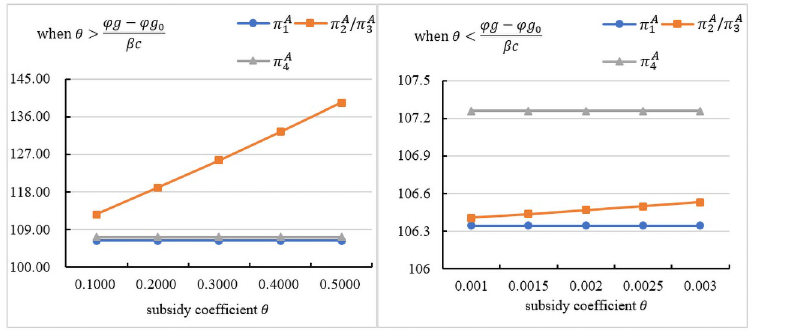
Fig 5. The influence of the subsidy coefficient on the assembler’s